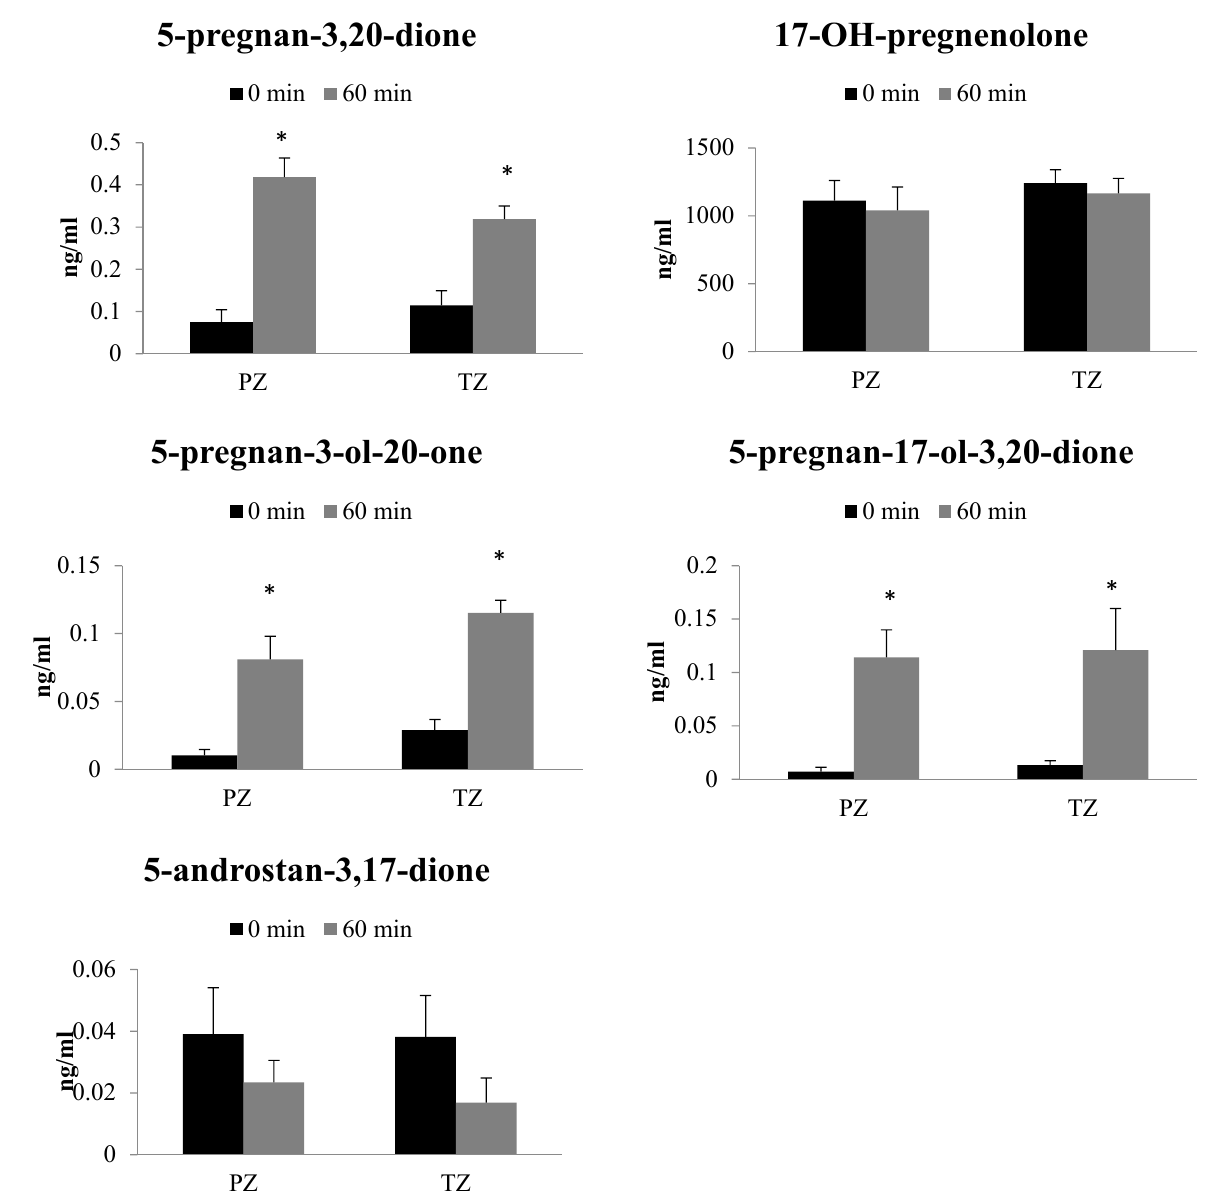
Figure 1. Steroidogenesis in peripheral zone (PZ) and transition zone (TZ) of human prostate cancer tissues following incubation with 17-OH-pregnenolone (2 µg/mL). Results are expressed as mean ± SEM (PZ n = 9; TZ n = 14). * indicates statistically significant differences ( p < 0.05) between 0 min and 60 min incubations with respective tissue zones. Table 2. Comparison (fold difference) of net steroid changes following 60 min incubation of 17-OH-